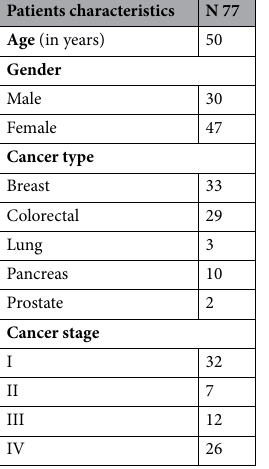
Table 1. Cancer patients